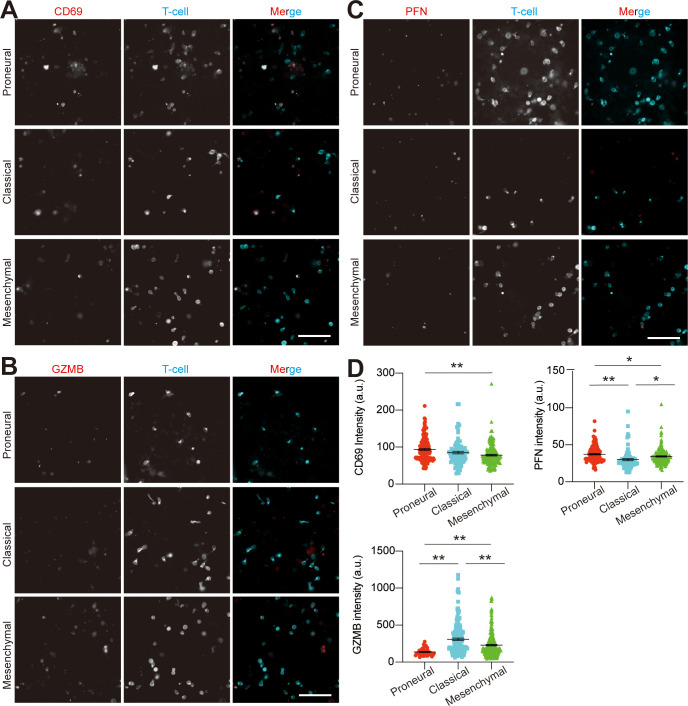
Analysis of allogeneic CD8+ T-cell activation in various GBM niches.The representative staining images showing (A) CD69, (B) granyme B (GZMB) and (C) perforin (PFN) expressions on CD8+ T-cells in MES (GBML91), CL (GBML08) and PN (GBML20) GBM niches. Scale bar, 100 μm. The quantified expressions were shown in (D). Noted the relatively lower expressions of T-cell activation markers in the MES GBM as compared to the CL or PN GBM. Surface marker expression was quantified by the mean fluorescent intensity of each cell. Error bars represent ± s.e.m. p-Values were calculated using one-way ANOVA. *, p<0.05, **p<0.01.